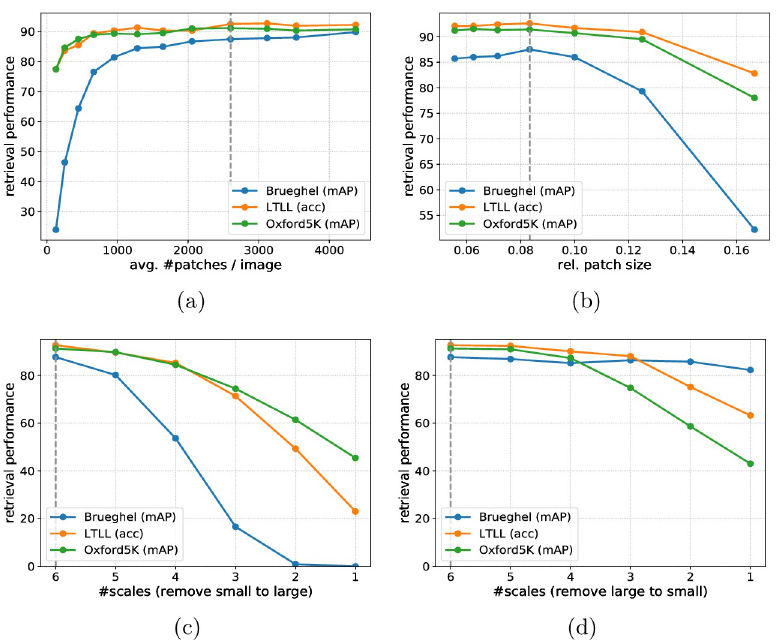
Fig 10. Effect of the local patch selection. Retrieval performance was measured for different average numbers per image (a), different sizes (b), and covered scales (c,d) for the patches on different datasets. We have successively reduced the number of scales starting with the smallest (c) and starting with the largest (d) local patches. We have marked our default configuration with a dashed line in each